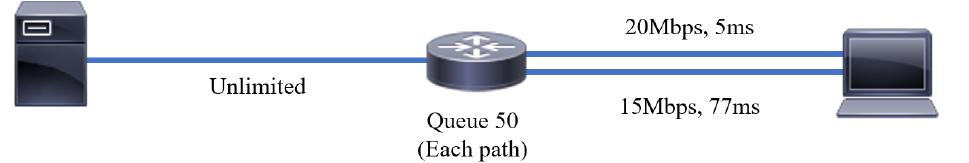
Figure 5. Network configuration with diverse RTT